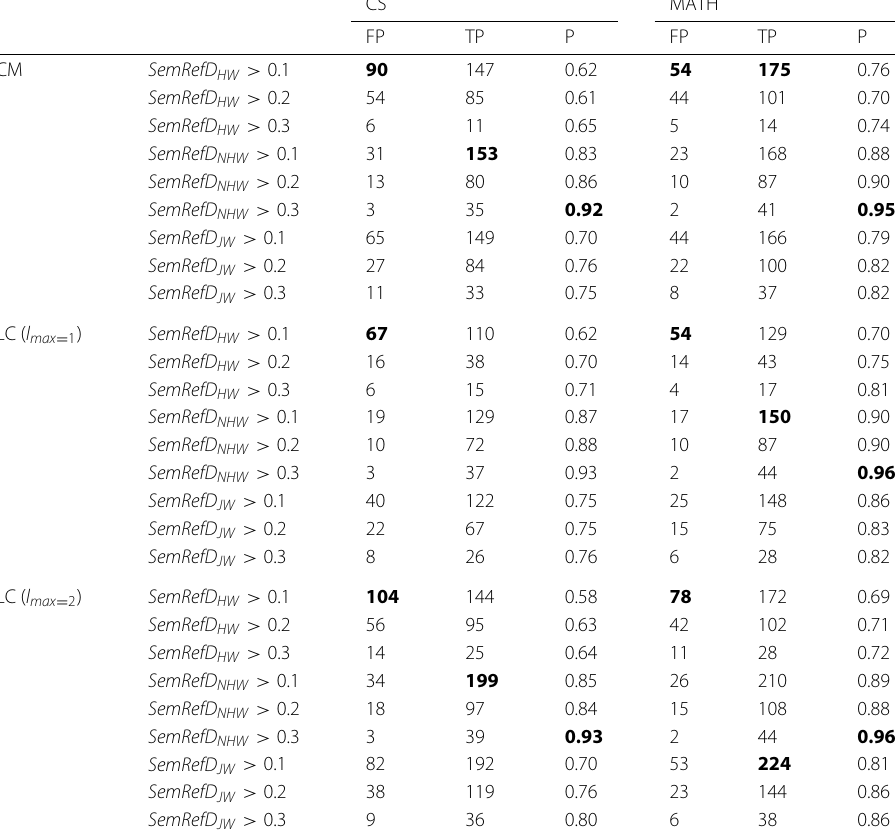
Table 5 Results of the complete process for CS and MATH target concepts using as evaluation metrics P (precision), TP (true positives), and FP (false